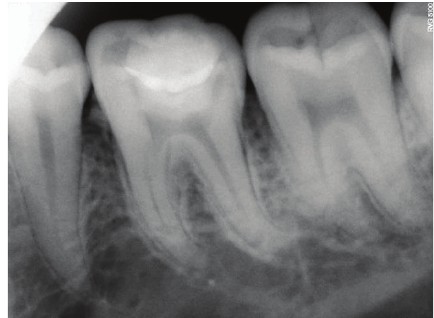
Figure 13: 24-month followup RVG 46.